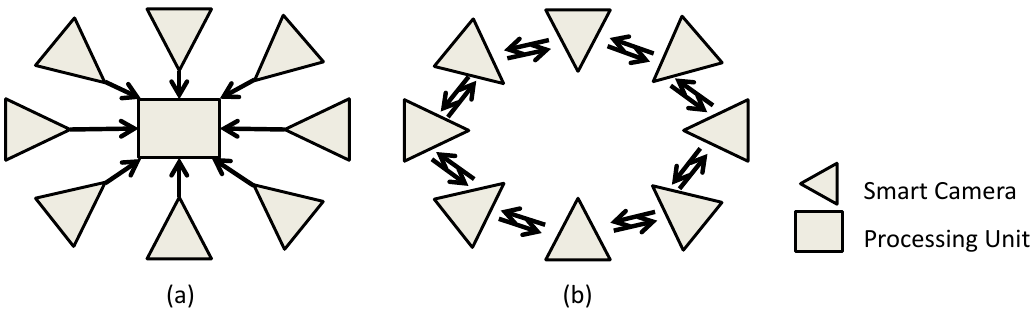
Figure 1. ( a ) Centralized camera network setup; ( b ) distributed camera network setup.